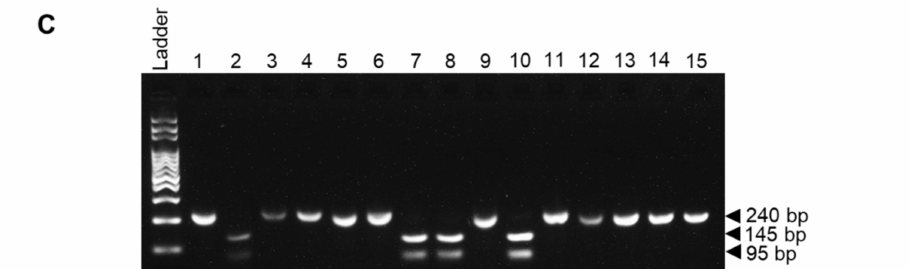
Figure 3. CAPS assay on CaM3 amplification products using ScaI. ( A ) ScaI restriction site (AGTˆACT) was only identified in C. jacksonii at the 95th base pair. ( B ) 240 bp amplification products using CaM3 primer set of fifteen Clarireedia spp. samples. ( C ) CAPS assay results targeting a SNP in C. jacksonii at the 95th base pair. The result was a (240 bp) band in C. monteithiana isolates (samples 1, 3–6, 9, 11–15) and two (95 and 145 bp) bands in C. jacksonii isolates (samples 2, 7–8, 10). ( B , C ) were performed on 11 isolates of C. monteithiana (1:2020-DS2, 3: 2020-DS4, 4: 2020-DS5, 5: 2020-DS6, 6: 2020-DS7, 9: